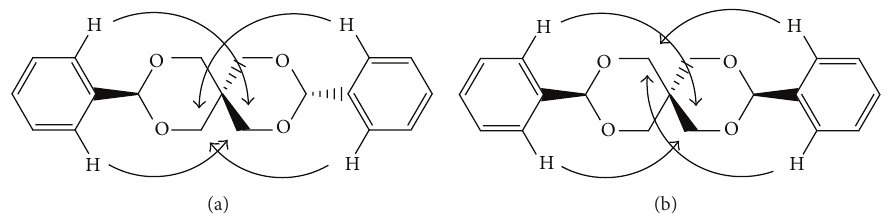
Figure 4: The H-H correlations of isomer (a) and (b).